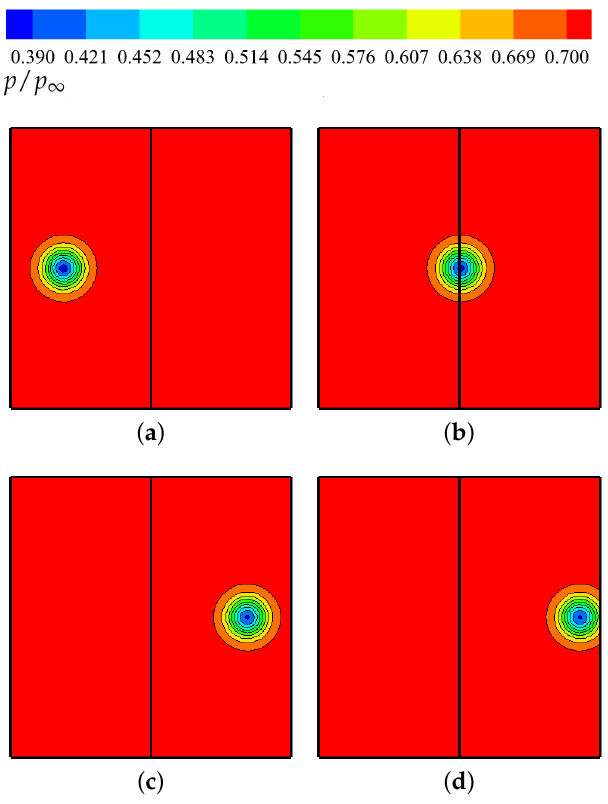
Figure 9. Pressure contours showing vortex convection across a block-interface boundary and illustrating its transparent nature to the flow. ( a ) t × a ∞ / L ref = 0; ( b ) t × a ∞ / L ref = 3.5; ( c ) t × a ∞ / L ref = 7; ( d ) t × a ∞ / L ref =